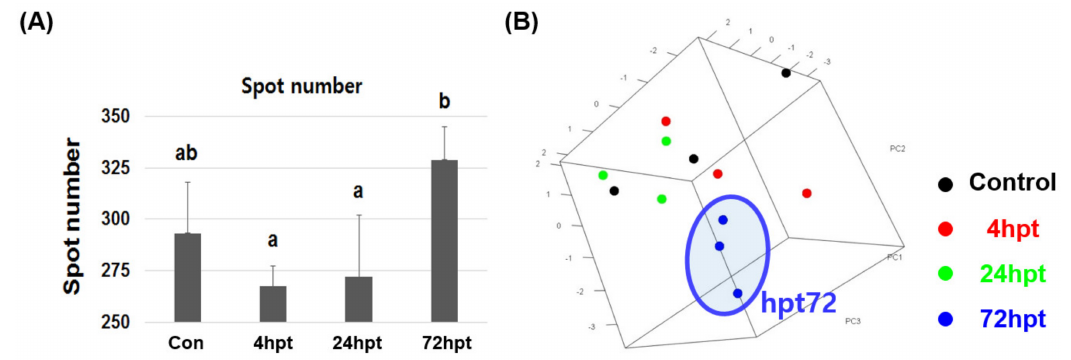
Figure 5. Number of detected spots in the control, 4, 24, and 72 hpt samples ( A ). 3D-PCA based on spot expression among groups ( B